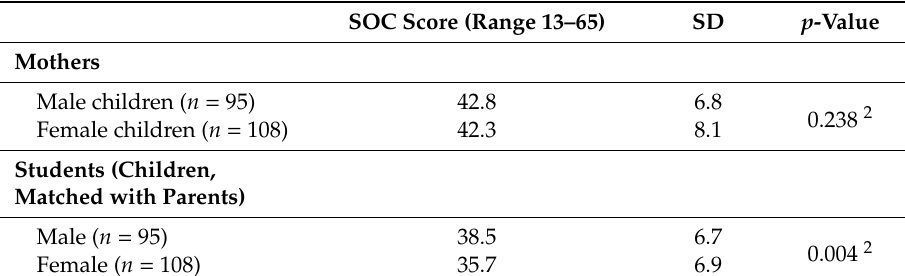
Table 2. Mothers’ and students’ average total SOC 1